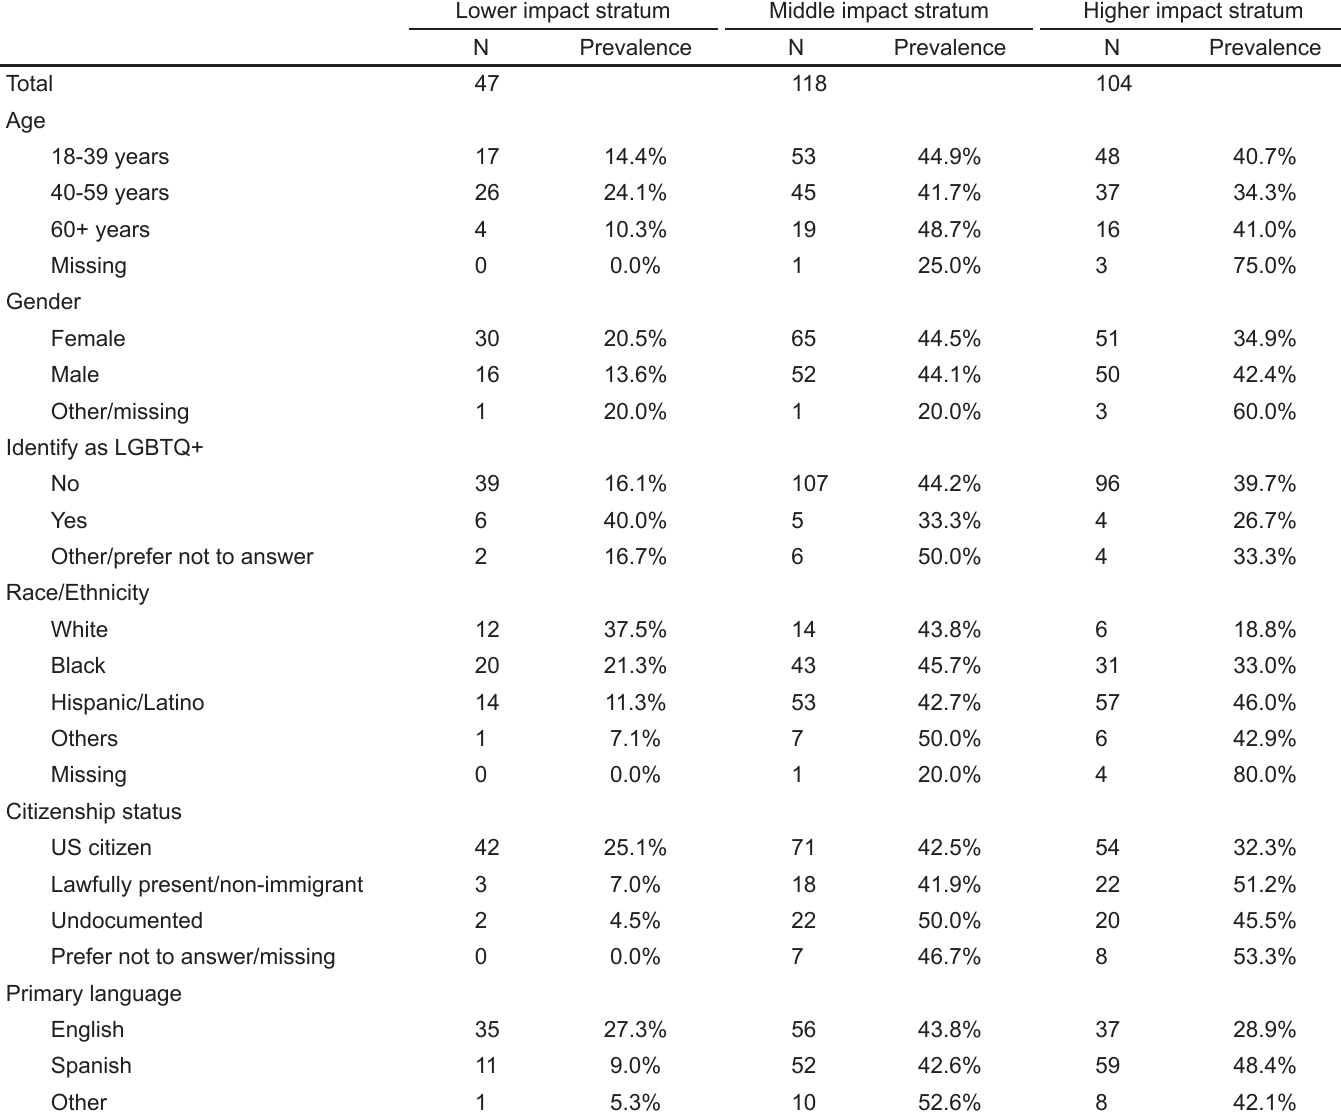
Table 2. Sociodemographic characteristics of patients visiting the emergency department based on their social determinants of health (SDOH) stratum (based on SDOH index score: lower impact stratum – index score 0-5; middle impact stratum – index score 6-10; and higher impact stratum – Index score